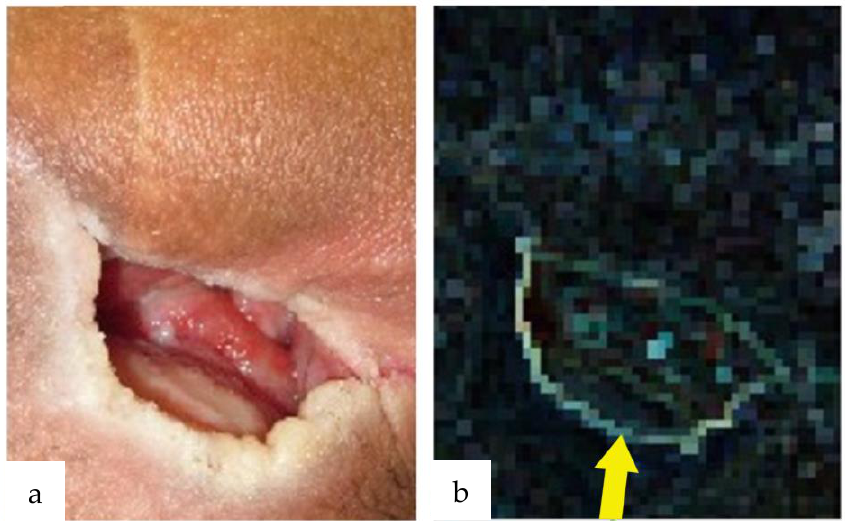
Figure 2. Depth of the wound depicted by the nearest neighbor method. ( a ) Decubitus ulcer with a subcutaneous pocket arising in the sciatic region. ( b ) The nearest neighbor method was used to superimpose the original image. The image shifted by 1 pixel at an angle of 45° and took the difference, resulting in a figure in which only the edge of the wound was highlighted (yellow arrow).